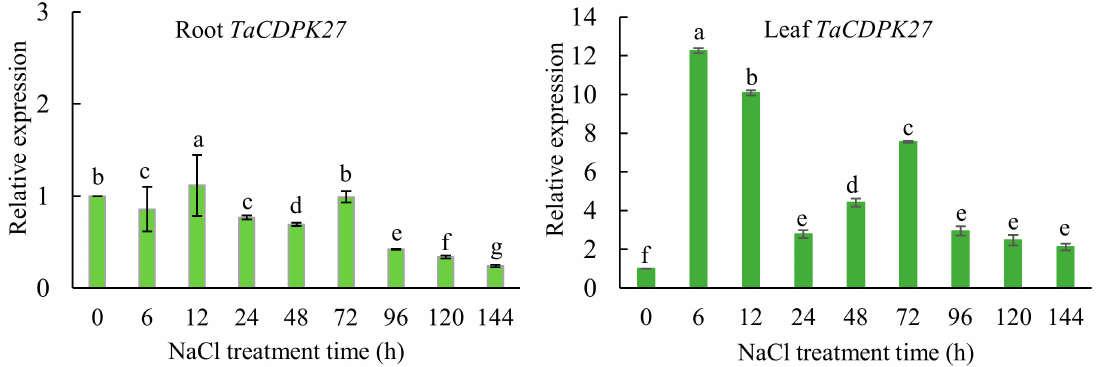
Figure 4. Transcript levels of TaCDPK27 in roots and leaves of wheat seedlings under NaCl treatment determined using qRT-PCR assay. Data were presented as mean ± SD from at least three independent experiments. Bars with different letters are significantly different at p <